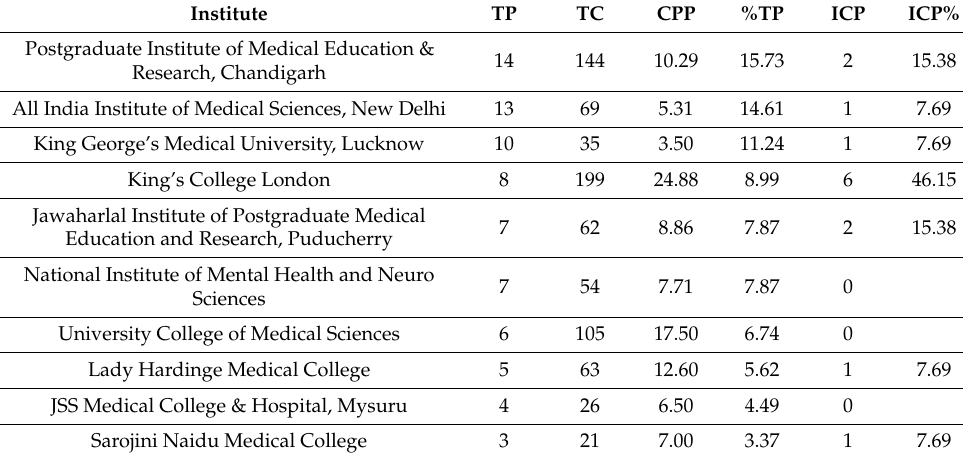
Table 3. The top ten institutions on dhat syndrome research (n = 89).